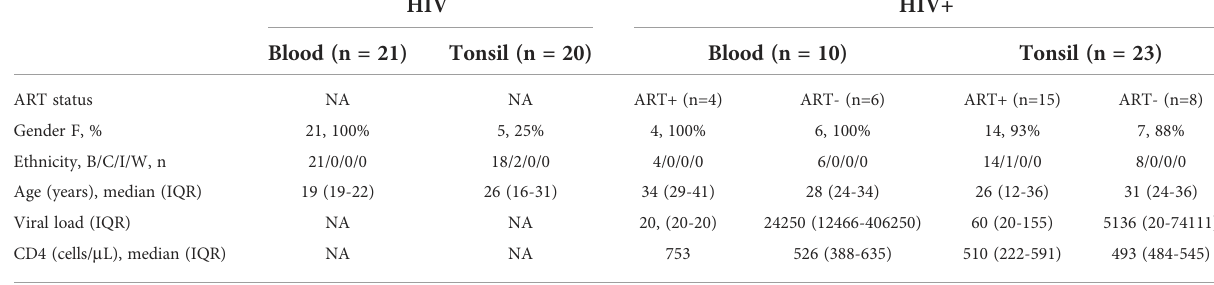
TABLE 1 Clinical characteristics of study participants